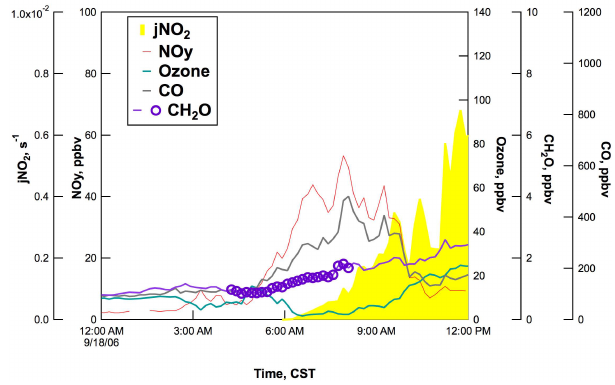
Fig. 5. Time series of the photolysis rate of NO 2 and the mixing ratios of NO y , O 3 , CH 2 O and CO observed during the morning of 18 September 2006 at Moody Tower. Small circles indicate the CH 2 O data for that day included in the linear regression illustrated in Fig. 4. Time is given as local standard time